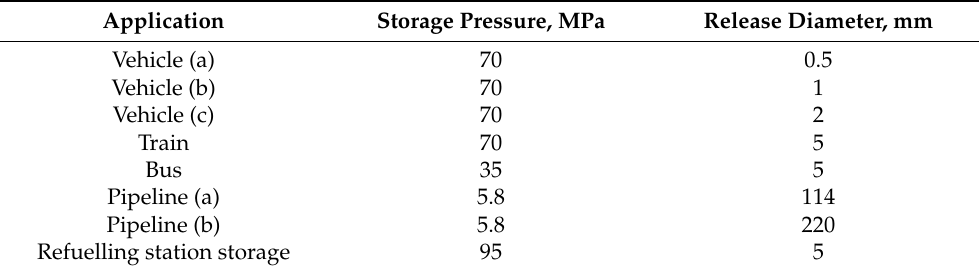
Table 3. Hydrogen applications selected for the assessment of hazard distances for humans from pressure effects and associated release parameters. The letters (a)–(c) stand for different release scenarios associated to a same example of application.